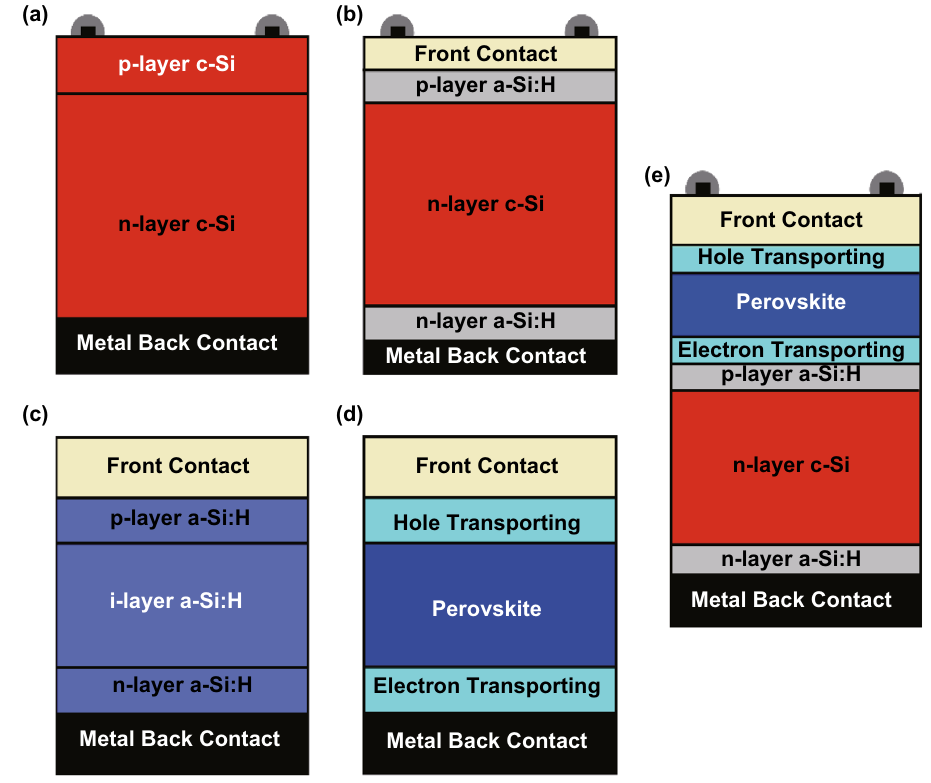
Fig. 1 Schematics of a crystalline silicon homojunction solar cell, b silicon heterojunction solar cell consisting of a crystalline silicon absorber and amorphous silicon contact layers, c amorphous silicon homojunction thin-film solar cell, d perovskite heterojunction thin-film solar cell, and e perovskite/silicon tandem solar